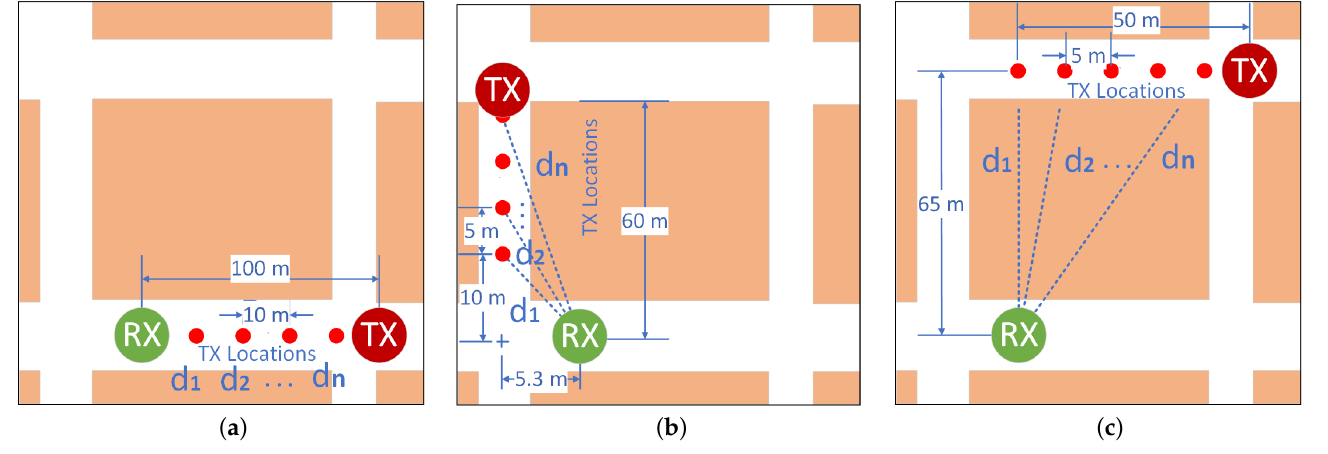
Figure 3. Measurement scenarios. ( a ) Line-of-Sight scenario, ( b ) Non-Line-of-Sight scenario (one